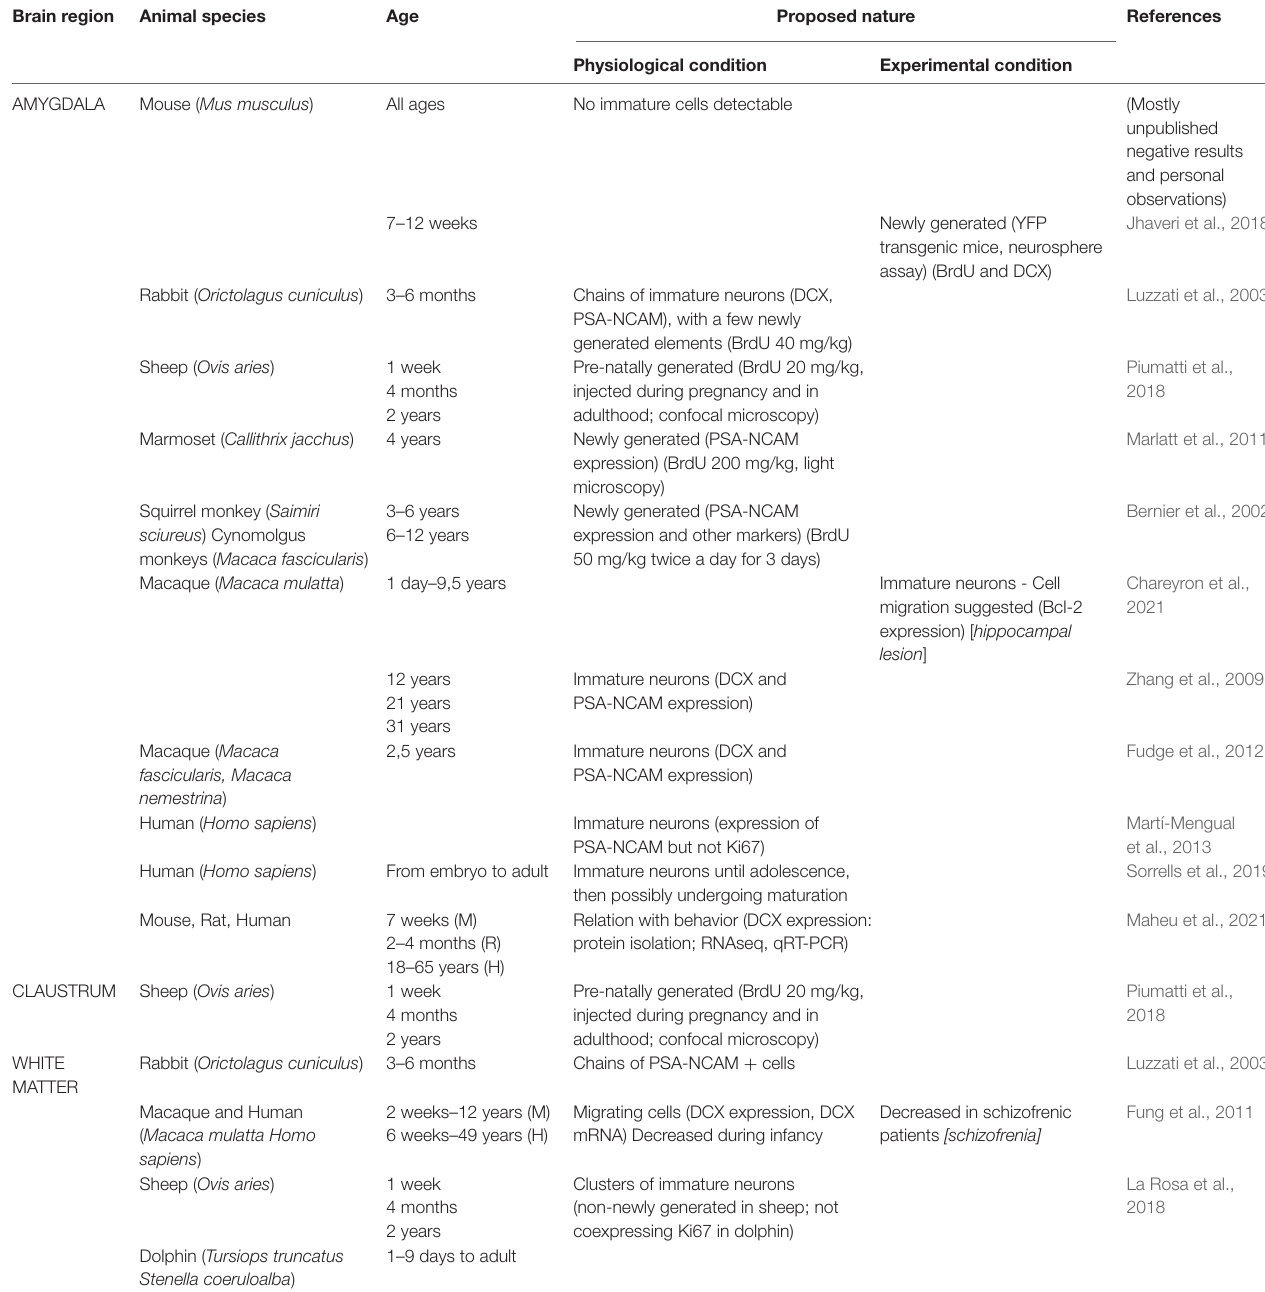
TABLE 1 | Detection of young, undifferentiated neurons in subcortical brain regions of mammals: interspecies differences and heterogeneous interpretation in the